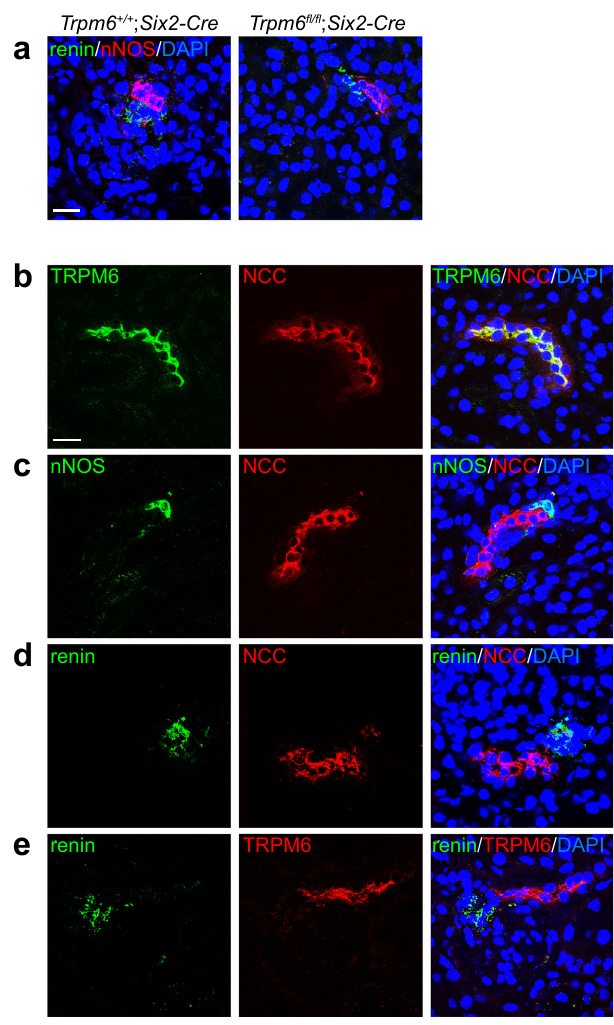
Fig. 3 TRPM6-expressing cells are adjacent to renin-secreting cells. a Cryosections of 2-month-old Trpm6 + / + ; Six2-Cre and Trpm6 fl / fl ; Six2-Cre mouse kidneys were subjected to immuno fl uorescence staining with an anti-renin antibody (green), an anti-nNOS antibody (red), and DAPI (blue). Bar, 20 μ m. A representative result from three independent experiments with similar results are shown. b – e Cryosections of 2-month-old Trpm6 + / + ; Six2-Cre mouse kidneys were subjected to immuno fl uorescence staining with the indicated antibodies and DAPI (blue). Merged images and monochrome images of each antibody staining are shown. Bar, 20 μ m. A representative result from three independent experiments with similar results are